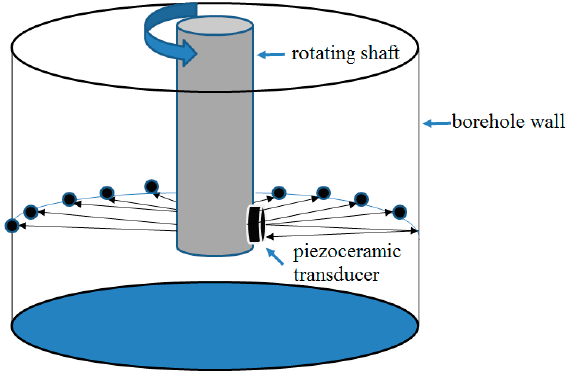
Figure 1. Diagram of the operating principle.